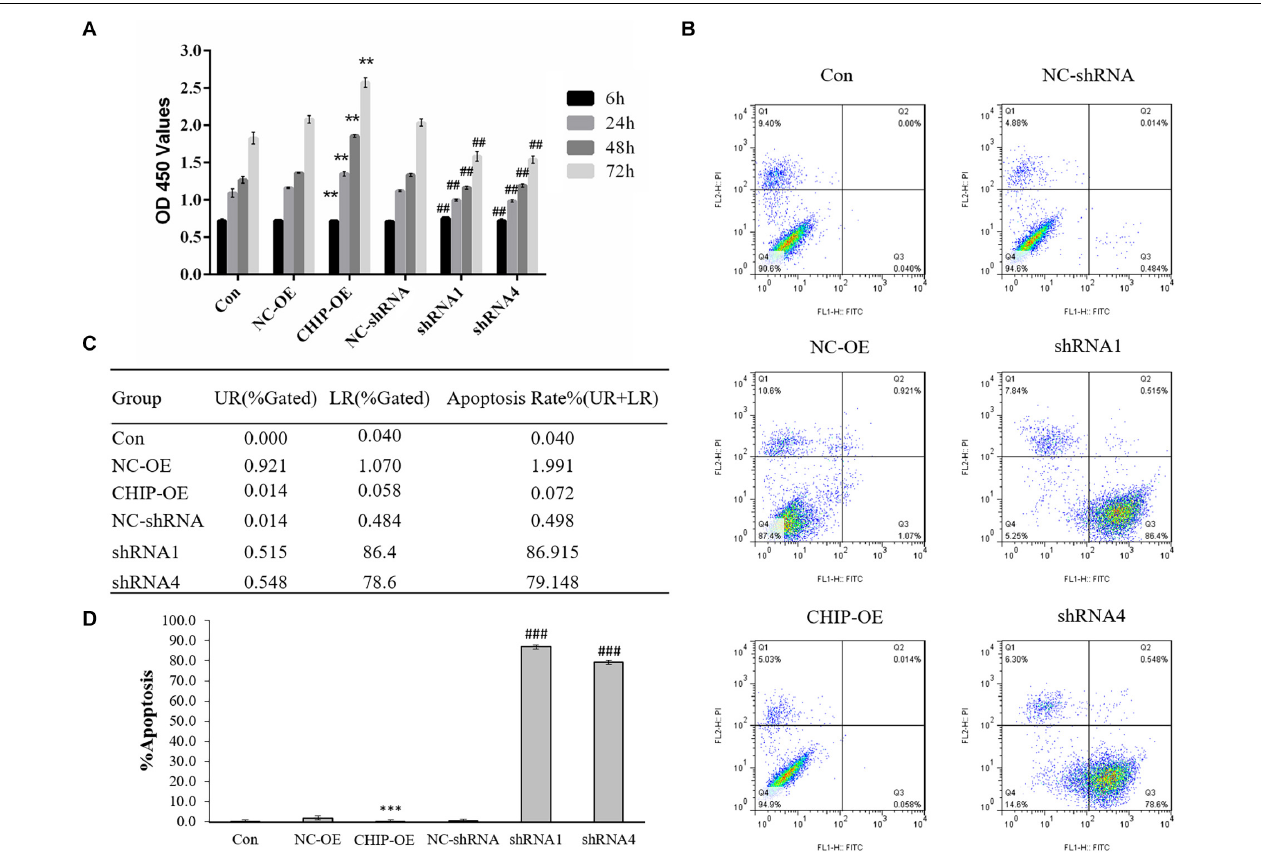
FIGURE 2 | C terminus of Hsc70-interacting protein (CHIP) overexpression promoted bEnd.3 cell growth after stretch-induced injury treatment. (A) CCK-8 assay was used to determine bEnd.3 cell viability. Cells were seeded in Bioflex 6-well plates for 12 h, followed by in vitro stretch-induced injury treatment. After 6, 24, 48, and 72 h, optical density (OD) value was measured at 450 nm. Experiment was performed in triplicate at different times. ∗∗ p < 0.01 vs. the NC-OE, ## p < 0.01 vs. the NC-shRNA. (B) Cells were seeded in Bioflex 6-well plates for 24 h, followed by in vitro stretch-induced injury treatment. 5 × 10 5 /ml treated cells were treated and analyzed by fluorescence-activated cell sorting cytometry. For each sample, at least 10,000 cells were analyzed. (C,D) Quantitative statistics of apoptosis rate. ∗∗∗ p < 0.001 vs. the NC-OE, ### p < 0.001 vs. the